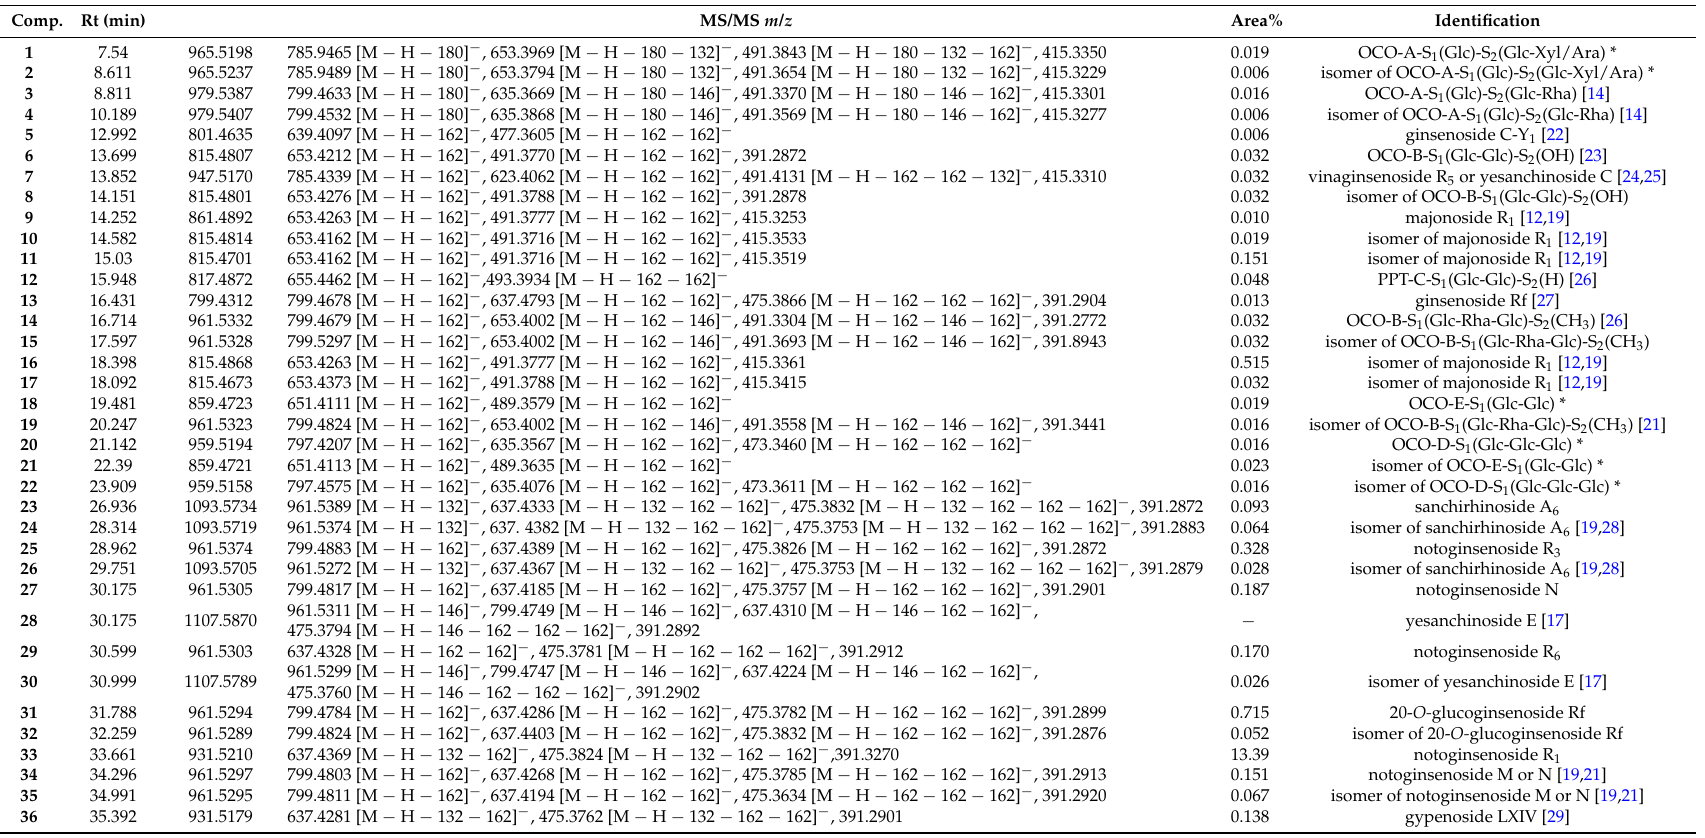
Table 2. Identification of compounds in